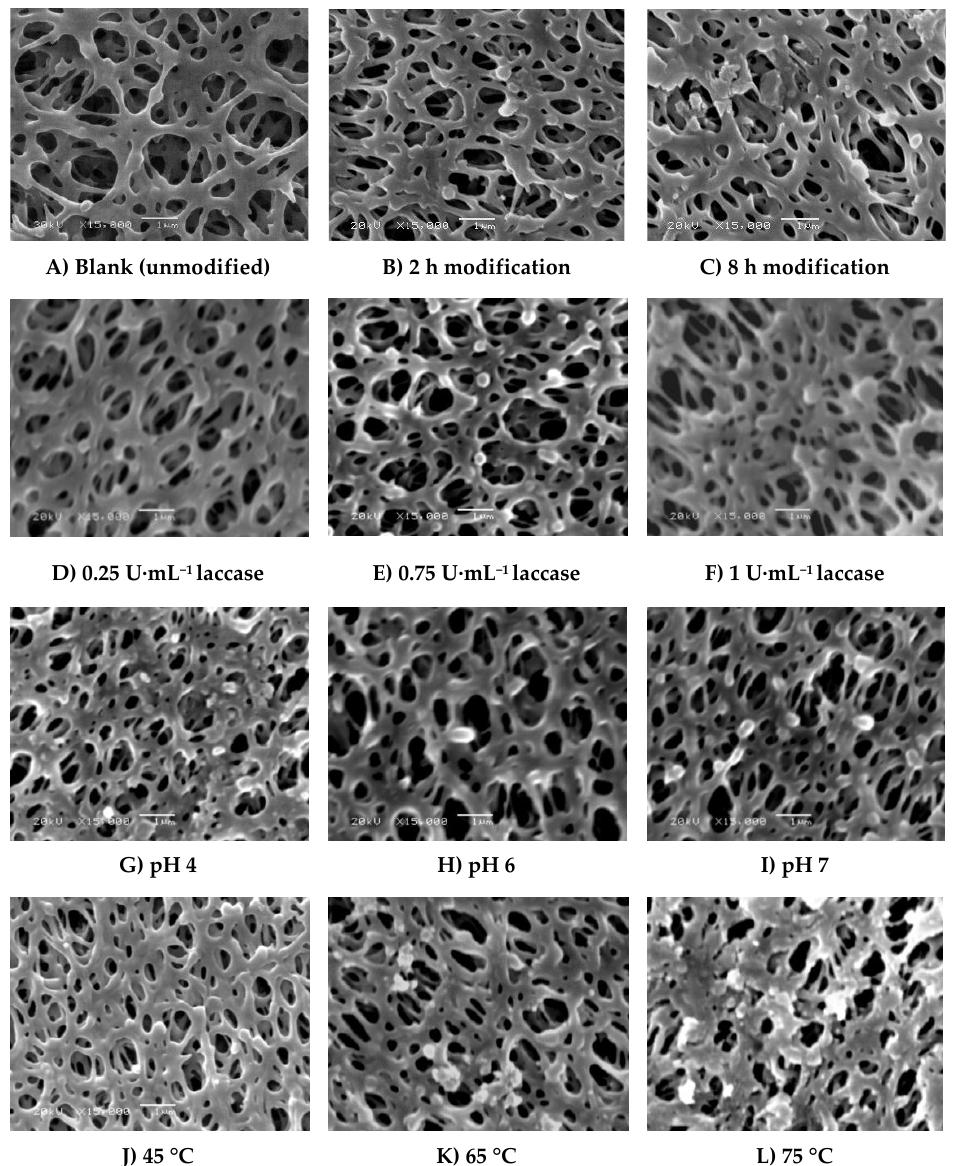
Figure 5. SEM photos (15,000× magnification, 1 µm bar) of real ( A ) blank membrane and modified membranes under different modification conditions. Common modification condition is ( B ) 4.8 mM ferulic acid, 0.5 U∙mL −1 laccase, 25 °C, pH 5, 0.1 M sodium acetate buffer, 2 h modification time. The effect of different modification conditions was illustrated as follows: ( C ) modification time (8 h); ( D – F ) modified membranes using 0.25, 0.75 and 1 U∙mL −1 laccase concentrations, ( G – I ) modified membranes at pH 4, 6, and 7, ( J – L ) modified membranes at 45 °C, 65°C, and 75°C with 0.5 h modification time.